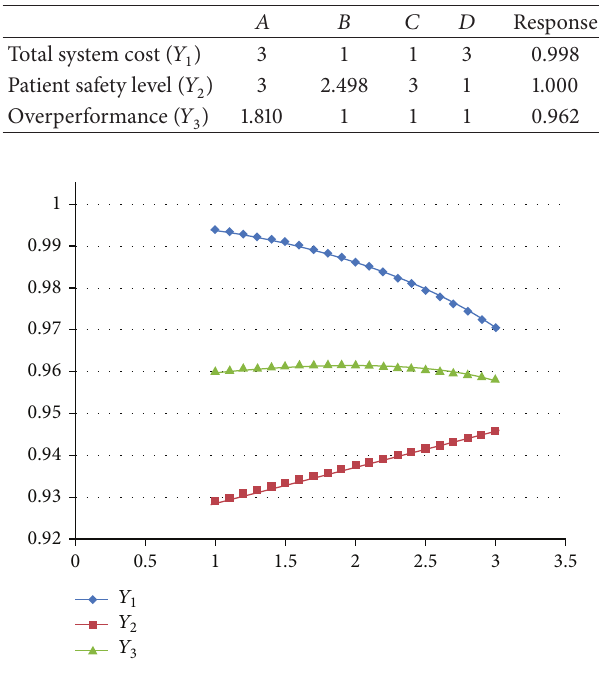
Figure 1: The changed safety stock levels affecting 𝑌 1 , 𝑌 2 , and 𝑌 3